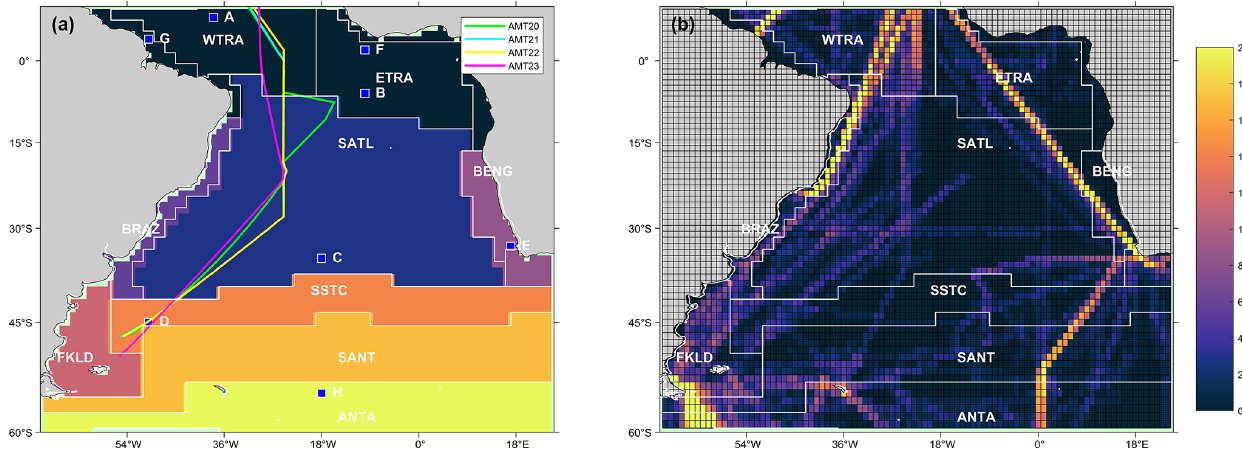
Figure 1. (a) Map of the eight static biogeochemical provinces in the South Atlantic Ocean, following Longhurst et al. (1995) and Longhurst (1998). Markers and letters indicate the locations of time series extracted from Fig. 3. The four Atlantic Meridional Transect (AMT) cruise tracks are also overlaid. (b) Map showing the spatial distribution of the SOCATv2020 data set used, where the data frequency is the number of available months of data within each 1 ◦ pixel. The province areas acronyms are listed as follows: WTRA is western tropical Atlantic; ETRA is eastern equatorial Atlantic; SATL is South Atlantic Gyre; BRAZ is Brazilian current coastal; BENG is Benguela Current coastal upwelling; FKLD is Southwest Atlantic shelves; SSTC is South Subtropical Convergence; SANT is sub-Antarctic and ANTA is Antarctic. Table 1. Uncertainties in the input parameters of the feed forward neural network used in Monte Carlo uncertainty propagation and pertur- bation